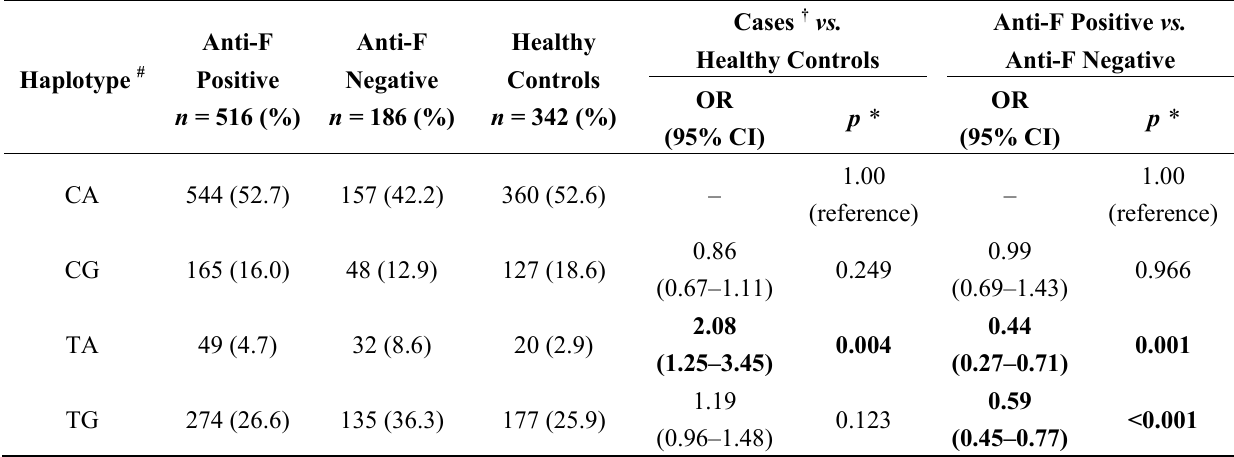
Table 4. Frequencies of haplotypes constituted with variant of rs3077 and rs9277534 between the two